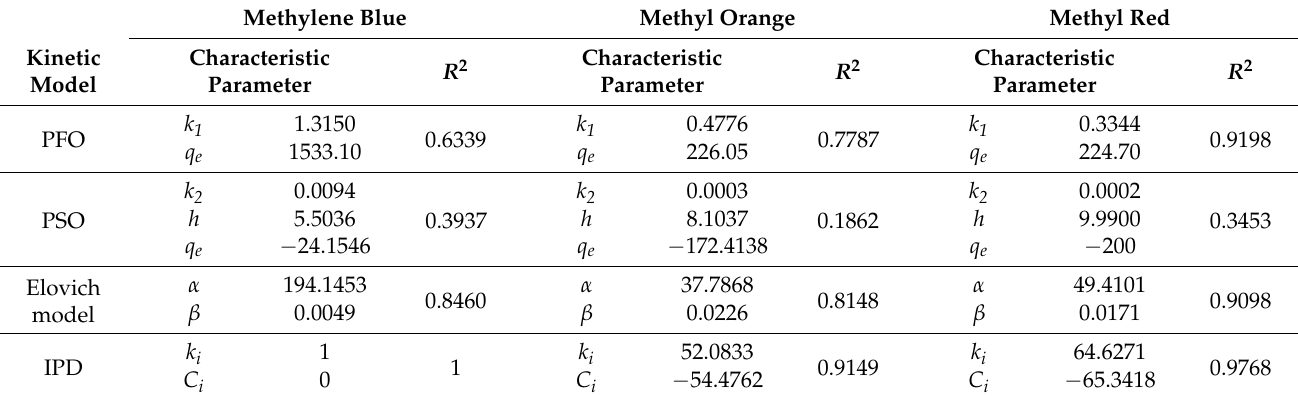
Table 1. Characteristic parameters obtained for the degradation of the organic dyes with the different kinetic models. Methylene Blue Methyl Orange Methyl Red Kinetic